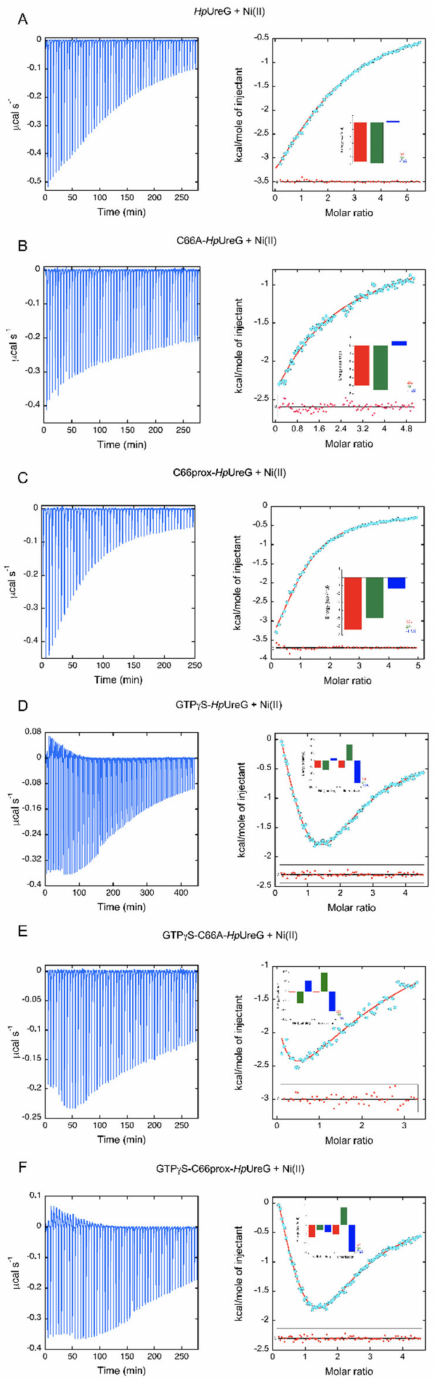
Figure 2. Isothermal Titration Calorimetry (ITC) of Ni(II) over Hp UreG and its variants in the presence and in the absence of GTP γ S in the sample cell. The panels on the left report the heat flow response for the injections of the metal ion over the protein solutions. The panels on the right show the respective integrated heat data (blue circles) and their best fit obtained using a single set of binding sites ( A – C ) or a model involving protein dimerization upon metal binding ( D – F ); the insets show the binding signatures ( ∆ G, ∆ H, − ∆ T, ∆ S) associated to each curve; the bottom plots show the residuals of the fitting